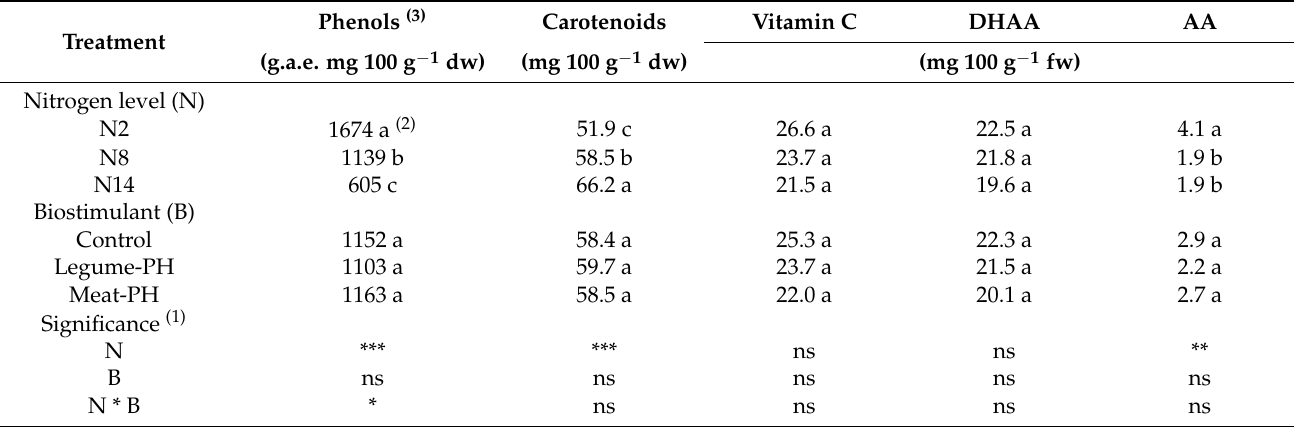
Table 6. The concentration of phenols, carotenoids, vitamin C, and its components—ascorbic (AA) and de-hydro-ascorbic (DHAA) acids—in spinach leaves as affected by nitrogen nutrition and by foliar application of biostimulants.